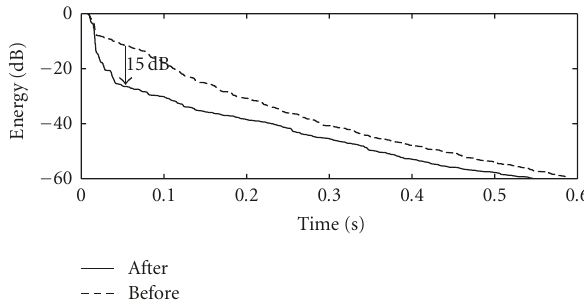
Figure 6: Energy decay curves of impulse responses before and after